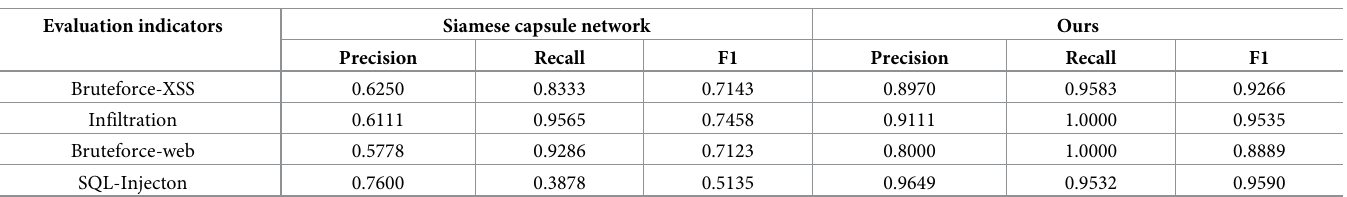
Table 4. Compare with Siamese capsule network. Evaluation